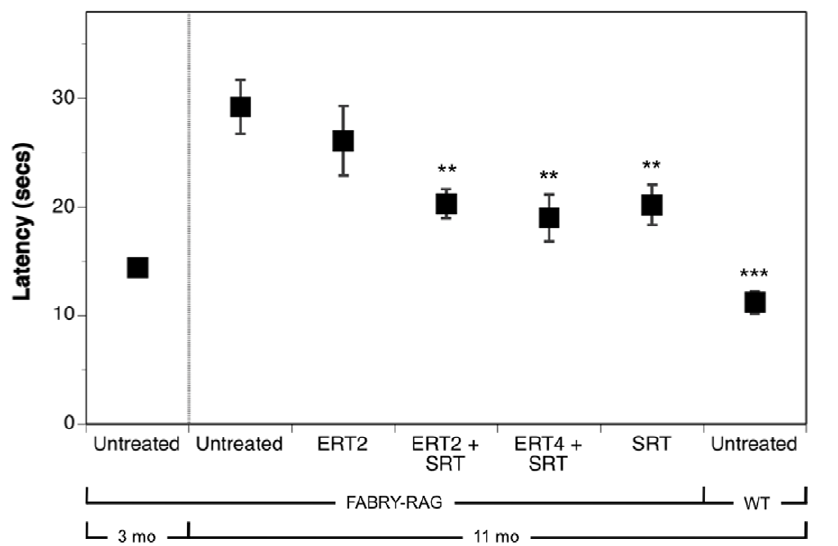
Figure 6. Substrate reduction therapy is most effective at delaying the onset of heat-insensitivity in Fabry-Rag mice. Treatments were begun at 3 months of age. Latency in treated Fabry-Rag mice and in an age-matched wild-type control group was measured at 11 months of age; a 3- month old untreated Fabry-Rag cohort was included for comparison. Mice were placed on a 55 u C hot-plate and the time for them to respond (latency) recorded. Latency is shown for wild-type mice, Fabry-Rag mice treated with ERT every two months (ERT2), ERT every two months + eliglustat tartrate (ERT2 + SRT), ERT every four months + eliglustat tartrate (ERT4 + SRT), eliglustat tartrate alone (SRT) and an untreated Fabry-Rag cohort. Data are shown as mean 6 SEM (n=10 mice/time point). Statistical comparisons are to the untreated Fabry-Rag mice at 11 months of age, and were determined using the Graphpad Prism software t test (*=p , 0.05; **=p , 0.01; ***=p , 0.001).